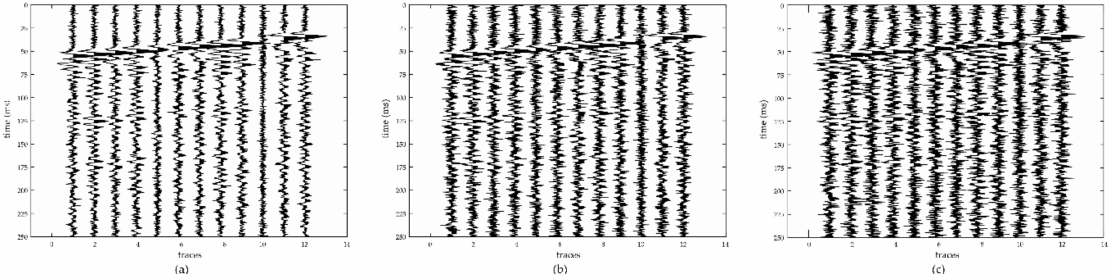
Figure 7. The 10th trace of the P-wave record is replaced by background noise, and the P-wave record is aminated by different levels of Gaussian white noises. ( a ) The signal-to-noise ratio of the first noisy data is 5 dB; ( b ) the signal-to-noise ratio of the second noisy data is 0 dB; ( c ) the signal-to-noise ratio of the third noisy data is − 2